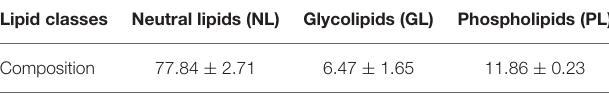
TABLE 1 | Composition (%) of the lipid classes a